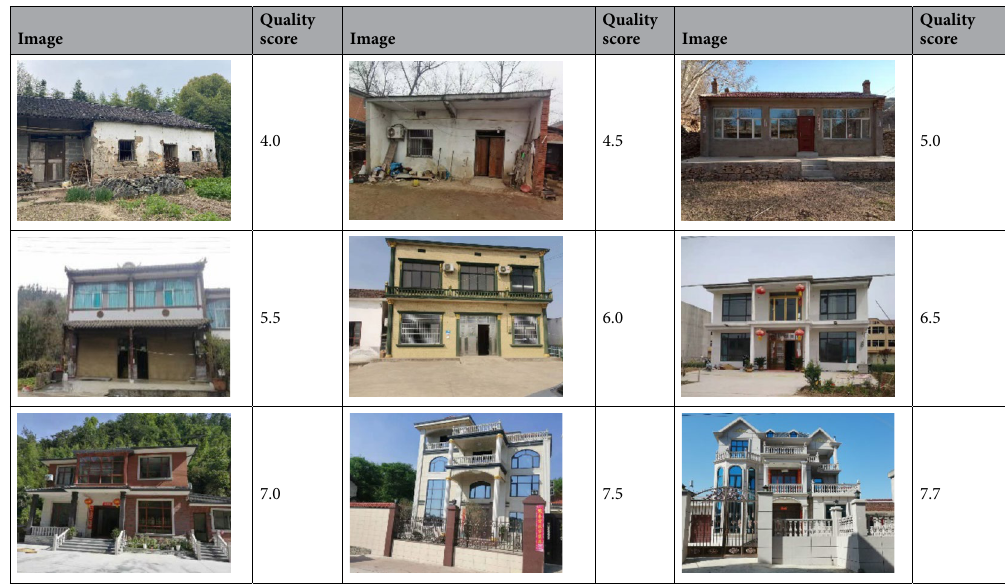
Table 2. Raw rural house images and their predicted scores of housing